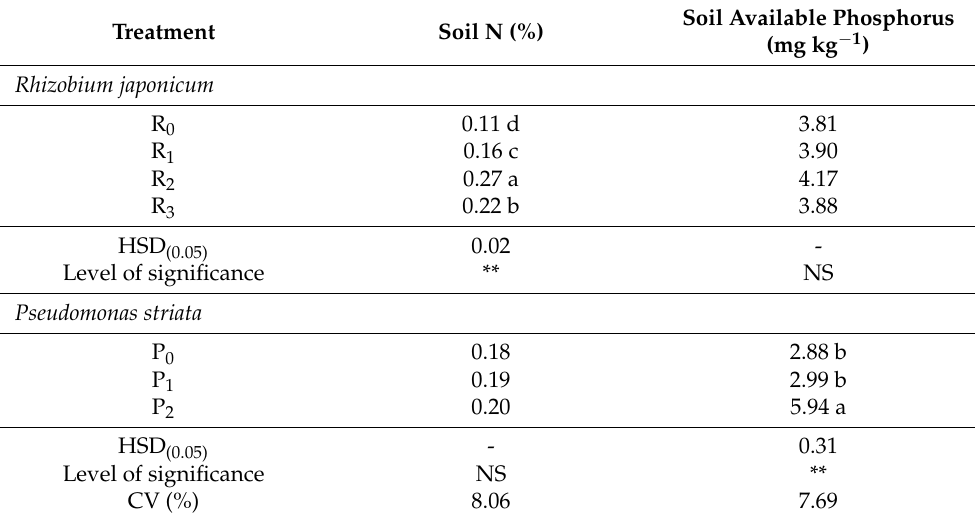
Table 7. Effect of Rhizobium japonicum and Pseudomonas striata on post-harvest soil nitrogen and available